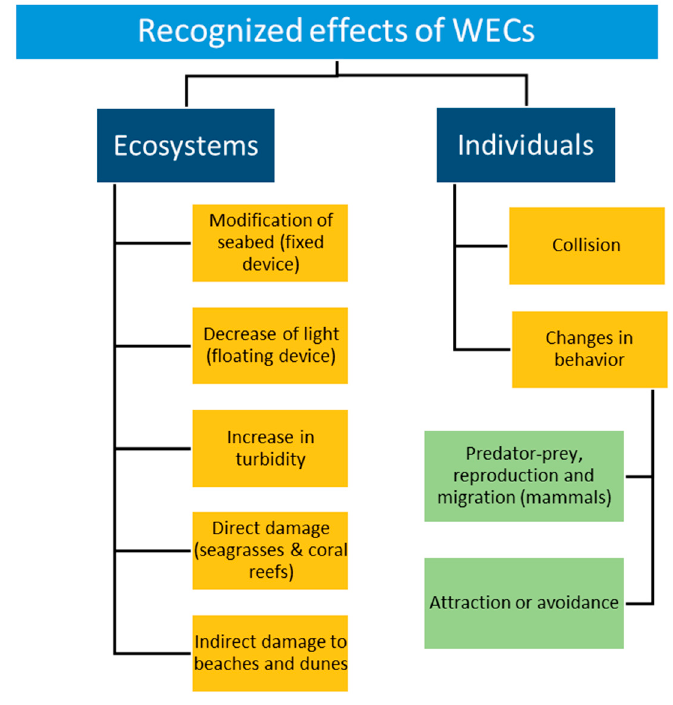
Figure 6. E ff ects on individuals and coastal ecosystems of Figure 6. Effects on individuals and coastal ecosystems of WECs.